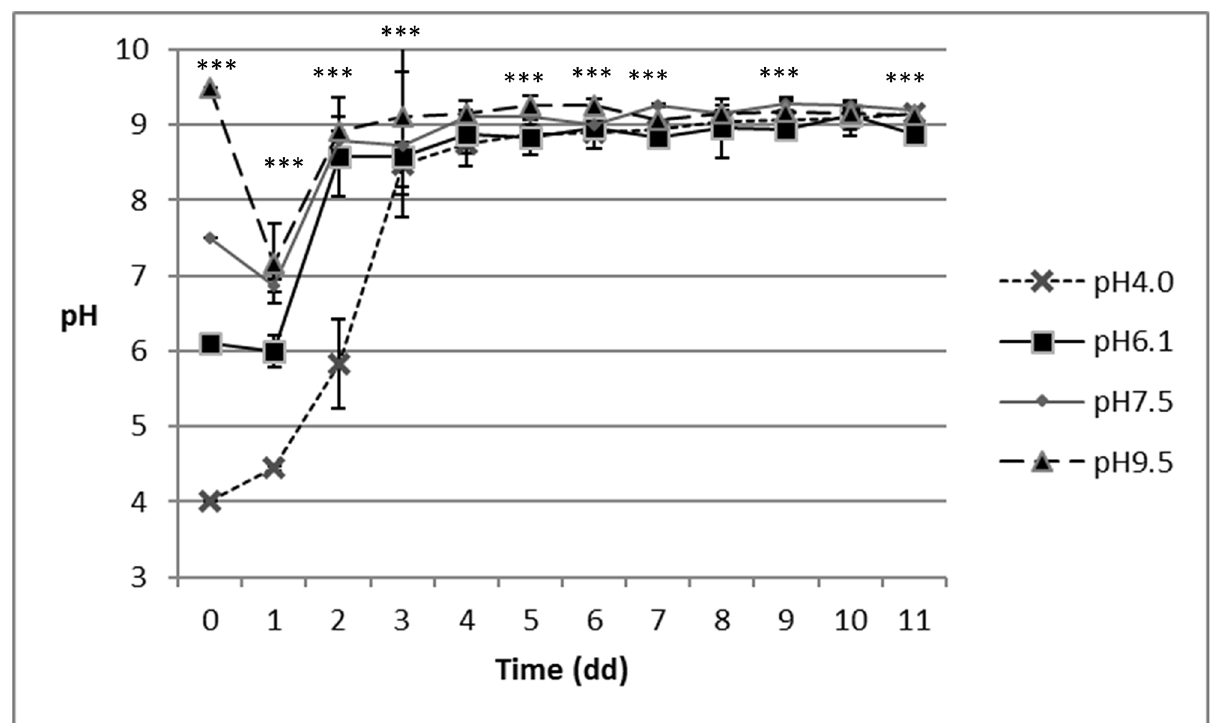
Fig 4. Changes in pH over the course of the experiment, as a result of the feeding system and pH treatment. DFS: daily allocated diet (40g/daily on WB).